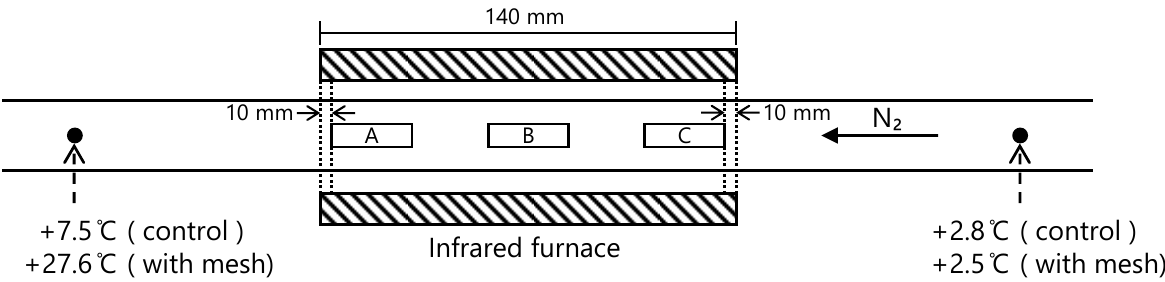
Figure 3. Positions ( A – C ) of Whatman cellulose samples in the reactor and changes in temperature at the upstream and downstream positions of the furnace during blank heating trials with and without a stainless steel mesh (4.0 kW/5 s irradiation/10 L/min nitrogen flow). The values shown here are the increases relative to room temperature.